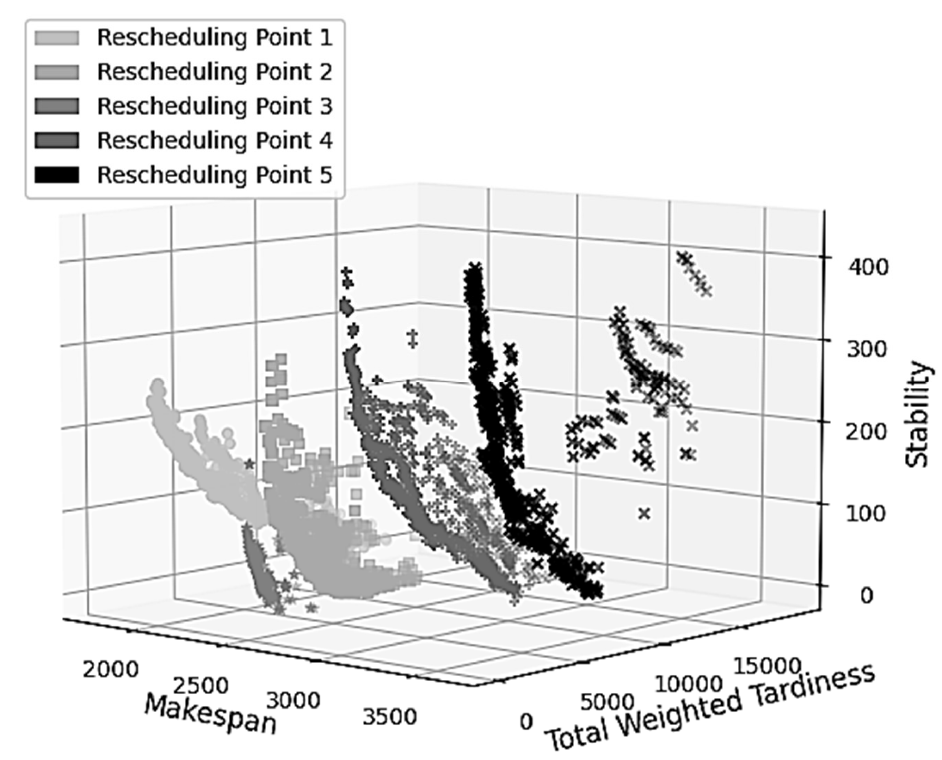
Figure 7. Dynamic Pareto evolution for RIPG in TA_20_10_3.